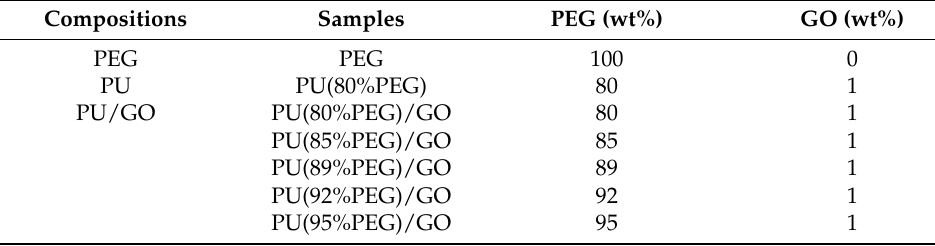
Figure 1. The synthetic route of PU/GO. Table 1. The compositions of PU/GO.